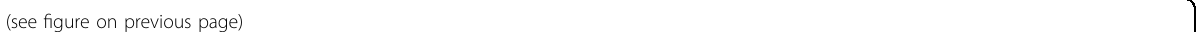
Fig. 1 Histological in fl ammation and immune cell in fi ltration of the skin of EC-challenged mice was inhibited by oral tolerance induction. A Experimental protocol. Mice were fed with or without 1% OVA in drinking water for 5 days prior to sensitization with two intraperitoneal injections of OVA-alum or OVA, followed by three consecutive EC challenges with OVA. The control mice were sensitized with PBS followed by EC challenge with PBS. B Hematoxylin and eosin staining of skin from the control (Con), EC-challenged (EC), and orally tolerized and EC-challenged (OT-EC) mice. The images are representative of two independent experiments. The scale bar represents 200 μ m. C The thickness of the whole skin (left), epidermis (middle), and dermis (right) of the indicated mice group. The graphs show the mean ± SD values. *** P < 0.001, **** P < 0.0001 (one-way ANOVA). D and E Immunohistochemical staining D and intensity quanti fi cation E of T cells (CD3e), neutrophils (Gr-1), macrophages (F4/80), and eosinophils (MBP) in the skin of the indicated mice. Images are representative of two independent experiments. The scale bar represents 200 μ m. The graphs show the mean ± SD values. * P < 0.05, ** P < 0.01, *** P < 0.001 (Kruskal – Wallis